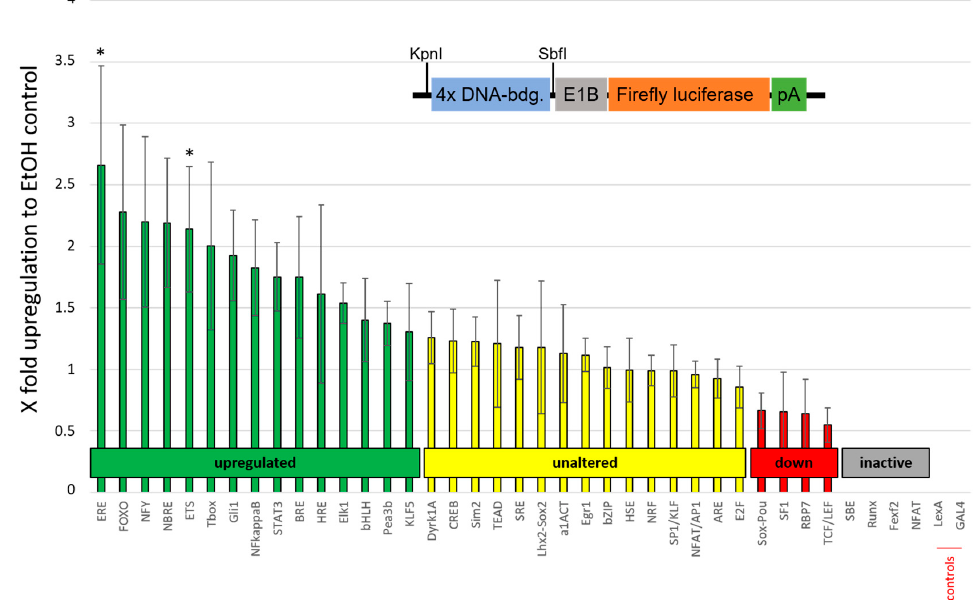
Figure 3. Erinacine C di ff erentially regulates reporter construct expression with binding sites for various transcription factors. Schematic drawing shows organization of Firefly luciferase reporter constructs containing a linear array of four consensus sequeces for transcription factor bindings sites (blue) followed by the weak basal promoter E1b (grey) and the cDNA coding for Firefly luciferase (orange) followed by the SV40 polyadenylation sequence (green). The sequences for the respective binding sites are provided in Table S1. Transcriptional activation of these constructs in 1321N1 cells upon incubation with erinacine C is displayed in relation to 0.5% EtOH solvent controls as fold-activation. Upregulated transcription above 1.3-fold over EtOH controls is shown in green color, while constructs with downregulated transcription below 0.7-fold with respect to EtOH controls are depicted in red color, these values for classifying and up- or downregulation were chosen arbitrarily for facilitating the readability of the data (four values per treatment, four independent cultures). * p < 0.05.